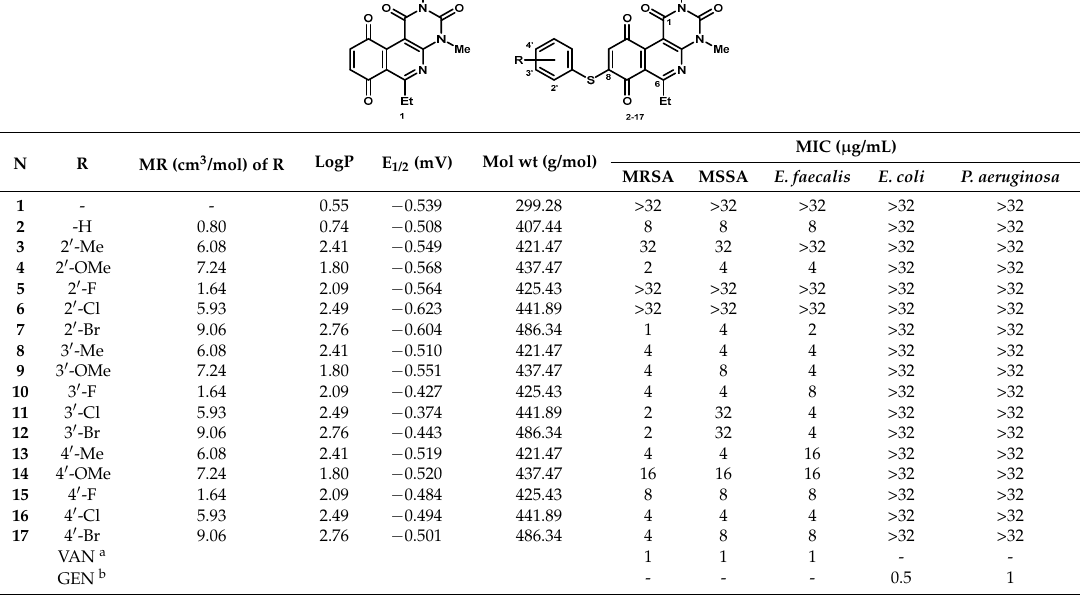
Figure 1. Synthetic route of the preparation of core 1 and compounds 2 – 1 7.